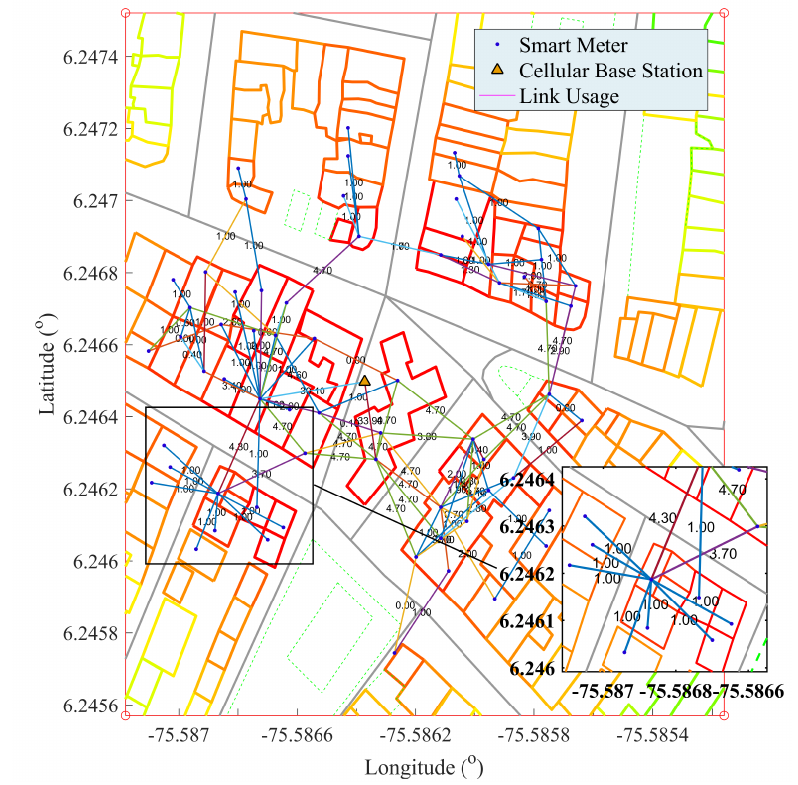
Figure 5. Accumulated occupation of the link by data